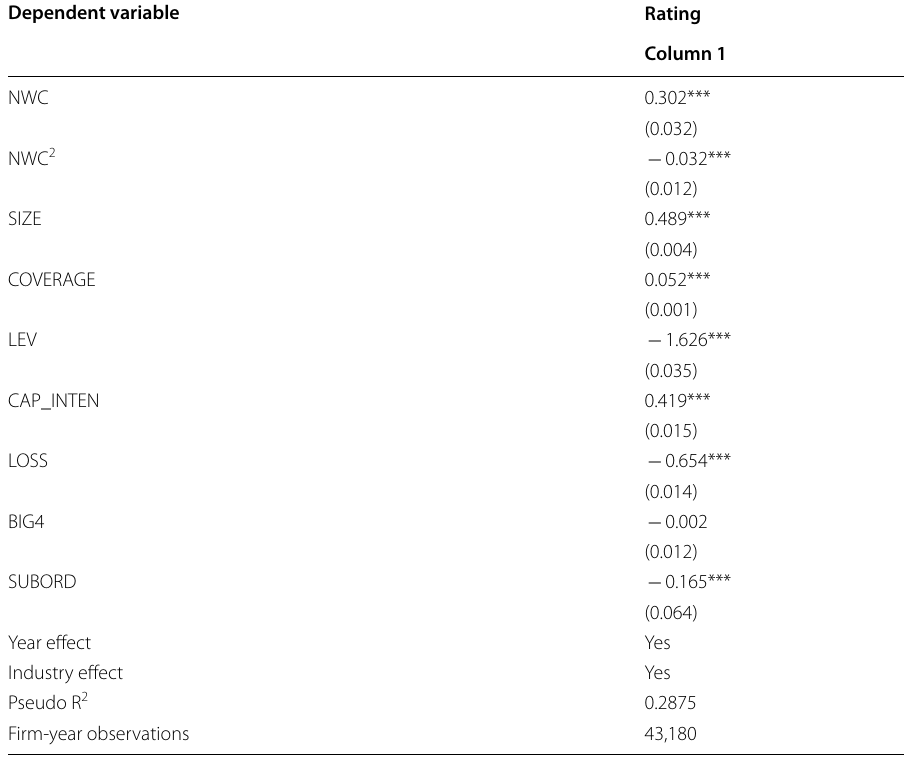
Table 6 Ordered Probit regression results of the non-linear relationship between credit rating and working